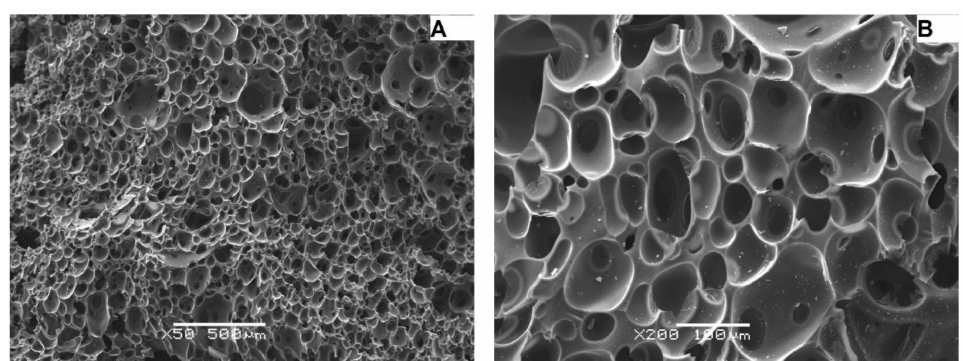
Figure 9. Micrographs of the carbon M2 sample taken with the use of SEM at various approximations: